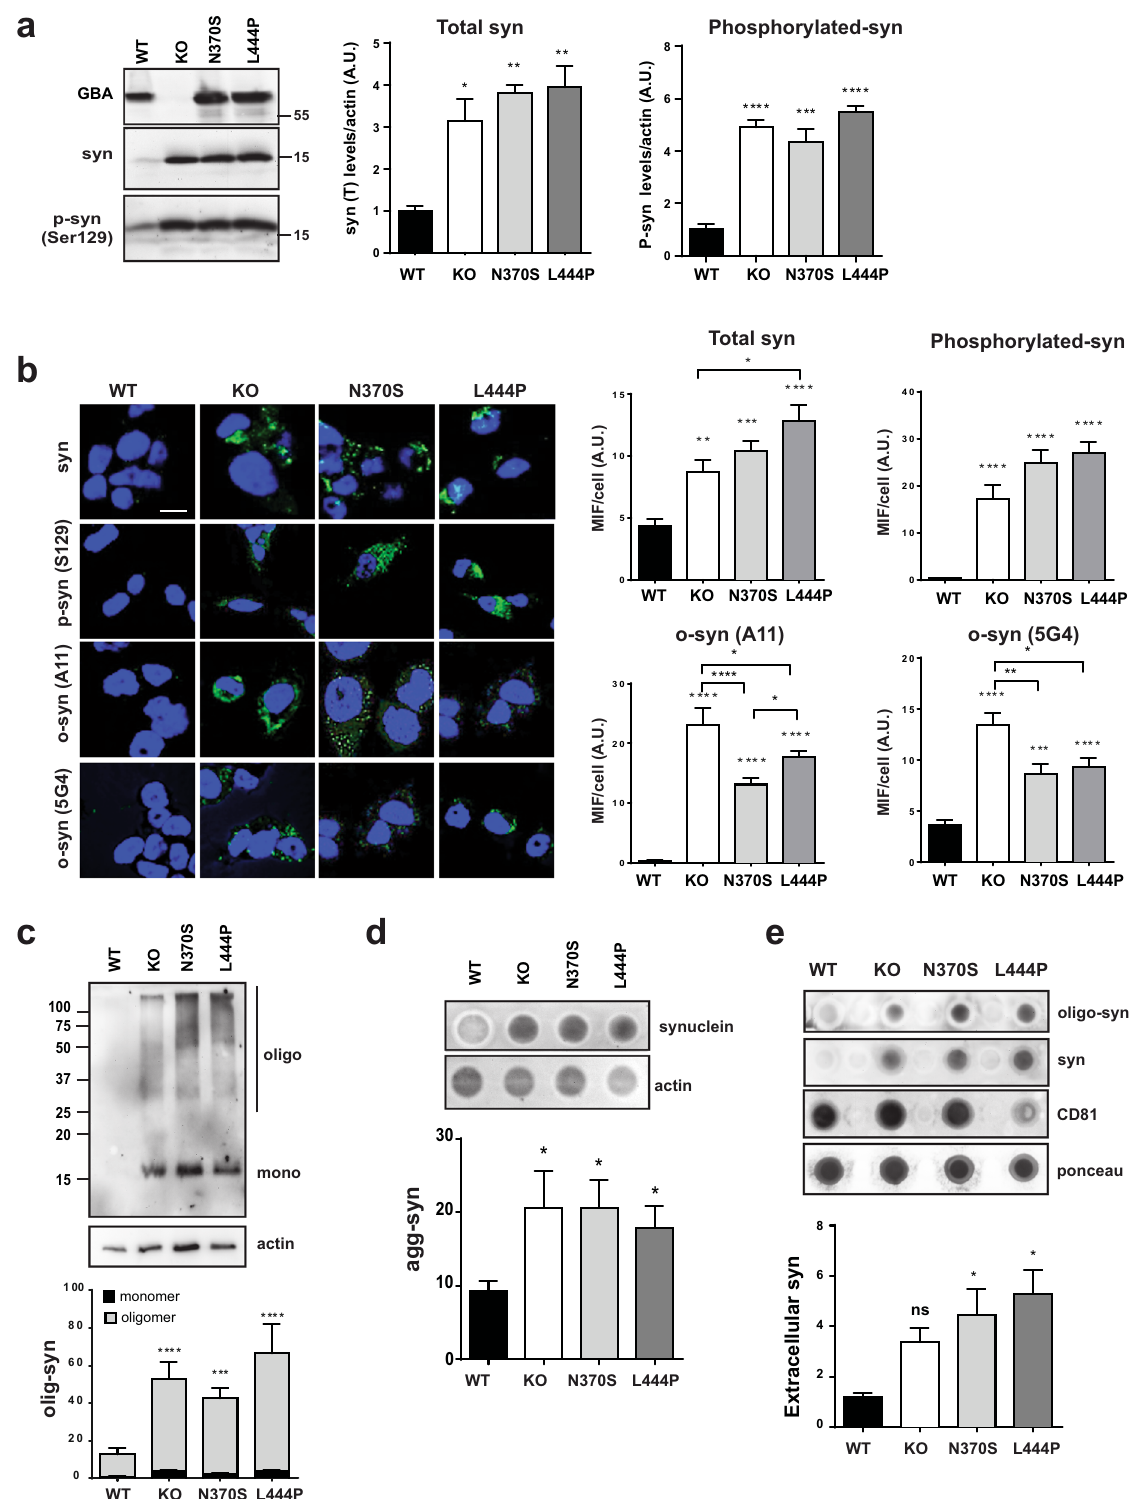
total LAMP-2A level was not changed in mutant or KO GBA cells. However, when analyzing the LAMP-2A levels exclusively in the lysosomal fraction, LAMP-2A levels were drastically decreased when GBA was knocked down or mutated. As expected, this decrease in lysosomal LAMP-2A expression (Fig. 6b)